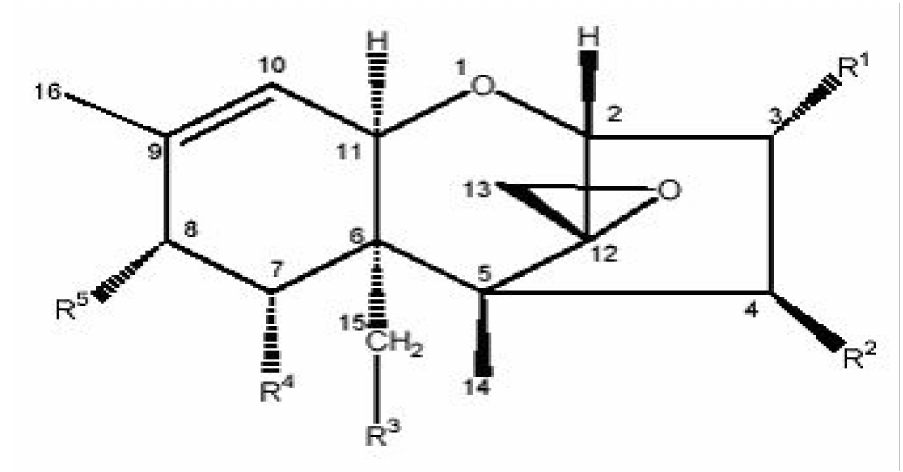
Figure 1. Basic structure of trichothecenes and their respective structures. Table 1. Trichothecenes and their